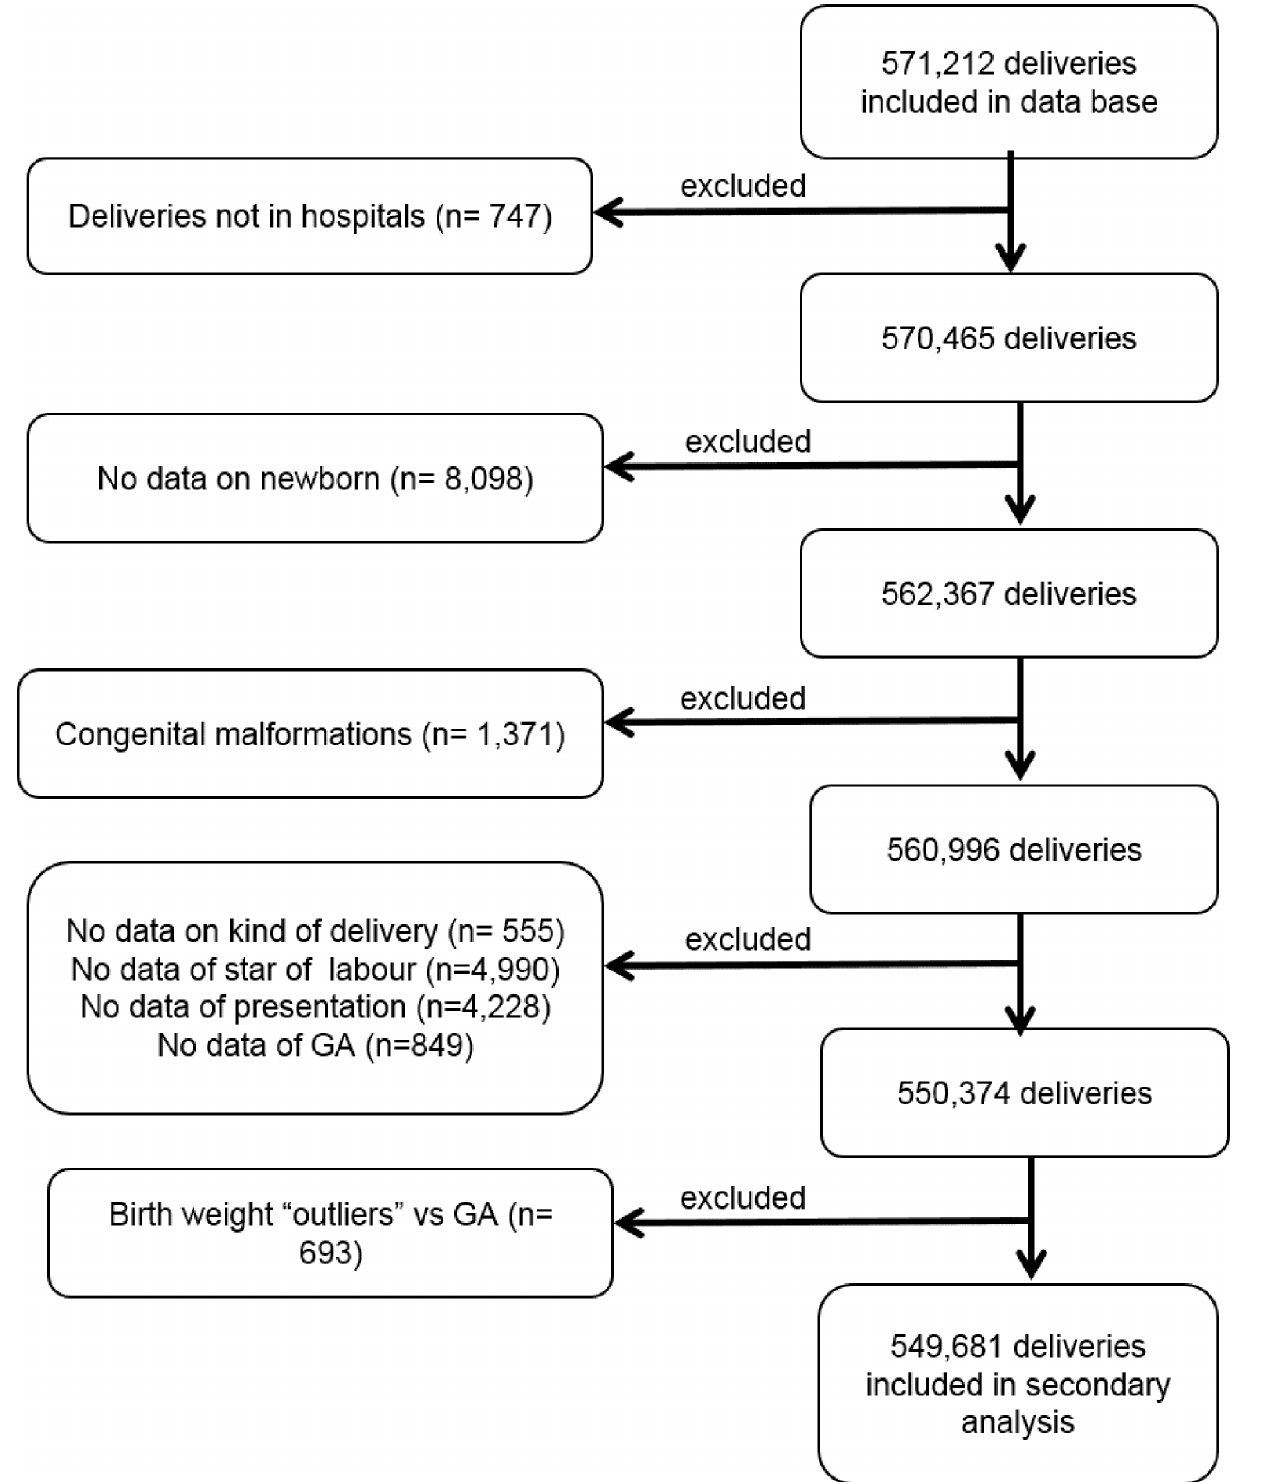
Fig 1. Flow chart of the selection of study participants of the 549,681 deliveries assessed in the secondary analysis.